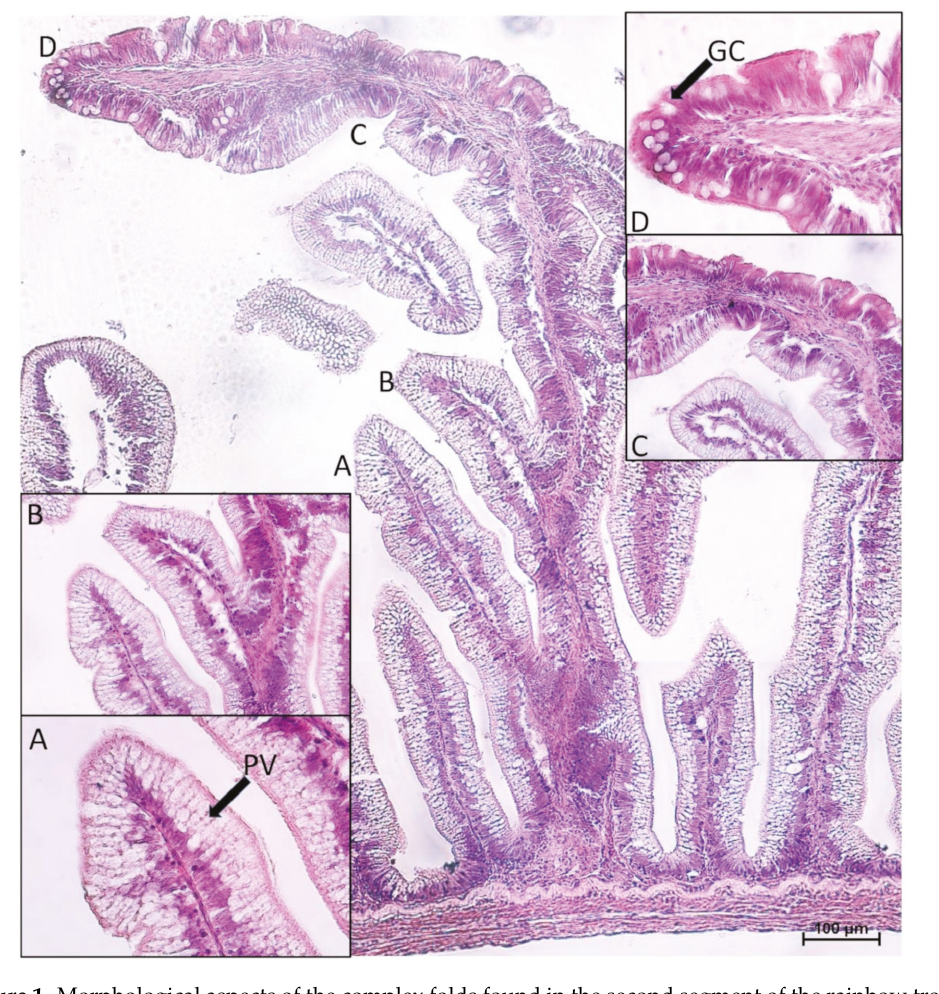
Figure 1. Morphological aspects of the complex folds found in the second segment of the rainbow trout mid-intestine. Basal part ( A , B ), characterized by a great amount of pinocytotic vacuolization (PV) that gradually disappeared ( C ). Apical portion ( D ), characterized by numerous goblet cells (GC) and no vacuolization. Hematoxylin–eosin para ffi n section.